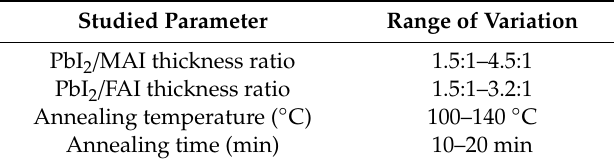
Table 1. List of studied deposition parameters of MAPI and FAPI films and corresponding variation range. MAI: methylammonium iodide, FAI: formamidinium